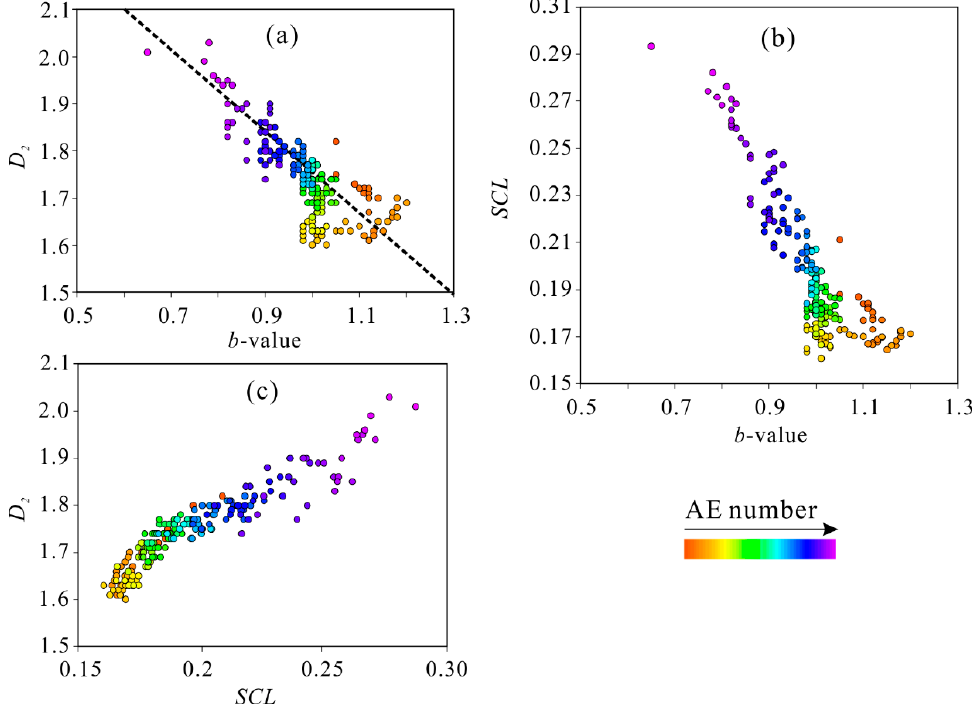
Figure 7. Plots showing correlations between b -value and fractal dimension ( a ), b -value and SCL ( b ), and SCL and fractal dimension ( c ). The data circles are colored according to AE number to show the temporal evolution